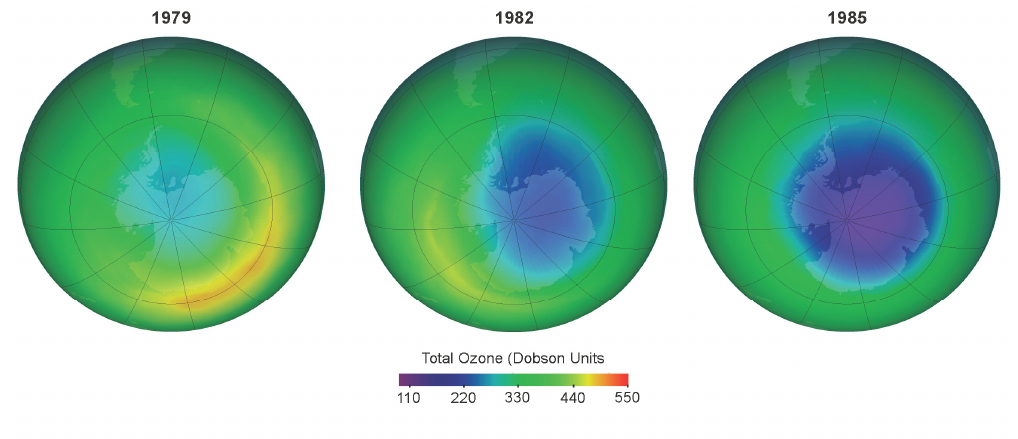
Figure 2. Size and depth (Dobson units) of the ozone hole in October of 1979, 1982, and 1985, as detected by TOMS